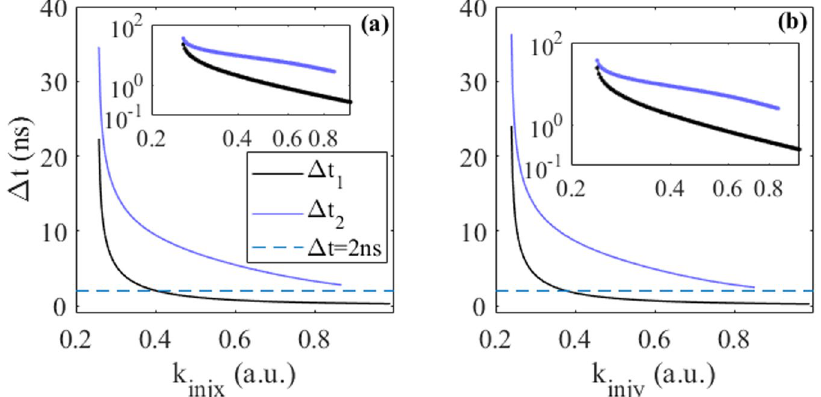
Figure 5. Δ t 1 (black solid line) and Δ t 2 (purple solid line) as functions of k injx under XP mode ( a ) and k injy under YP mode ( b ). The dashed blue line represent Δ t = 2 ns. The insets are the corresponding log-log plots.